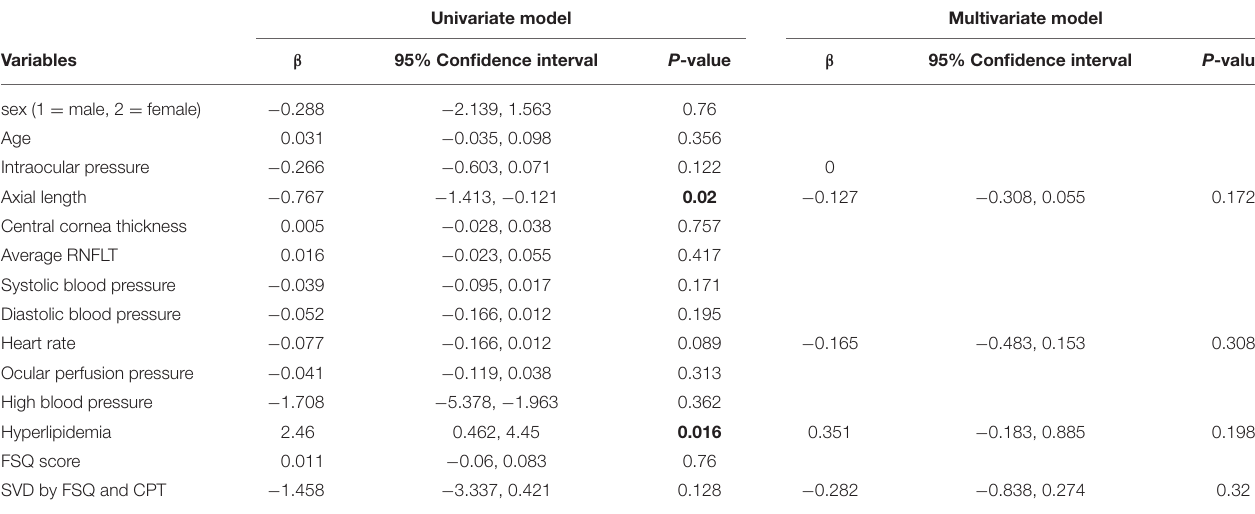
TABLE 5 | Univariate and multivariate generalized estimation equation analyses for factors associated with RPC vessel density in the inferotemporal sector. Univariate model Multivariate model